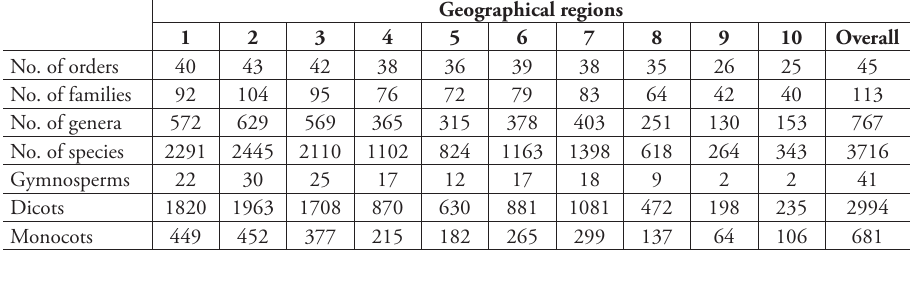
Table 1. Numbers of seed plant orders, families, genera and species in each geographical region of Xinjiang. Regional division of Xinjiang is shown in Fig. 1.